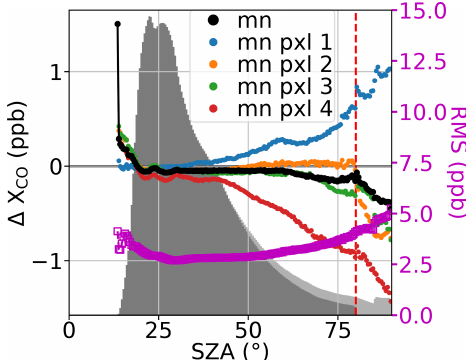
Figure 3. Example diagram showing the small-region approxima- tion (SRA) bias as a function of solar zenith angle for water. The black points show the overall mean (mn) bias (minimum 2000 points), the magenta points show the RMS, and the other points show the mean bias for the individual pixels (minimum 300 points). The lighter histogram is of all the data. The darker histogram is data remaining after the SZA and snow or ice filters. Figures like this are used to make filters for and check for bias in MOPITT L2 data. The red line is the filter cutoff at 80 ◦ . The equivalent diagram for land, along with diagrams for other features, is in Sect.